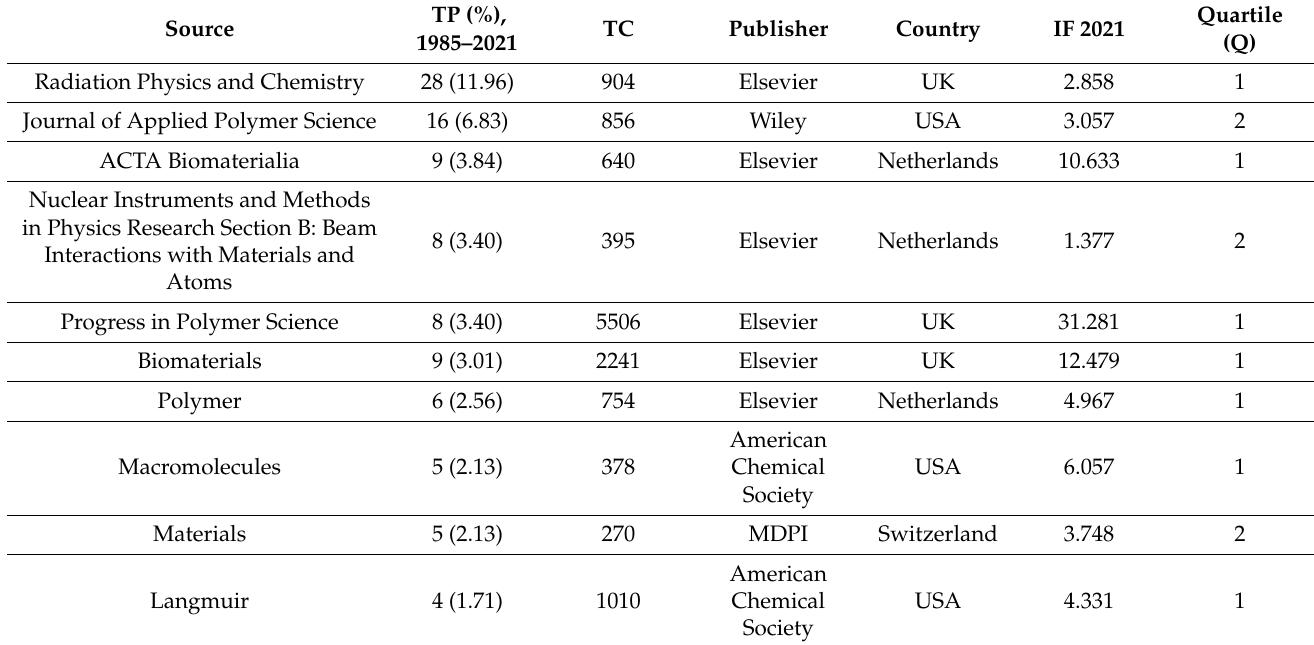
Table 2. Highly influential journals in relation to published articles on FPBMs prepared by